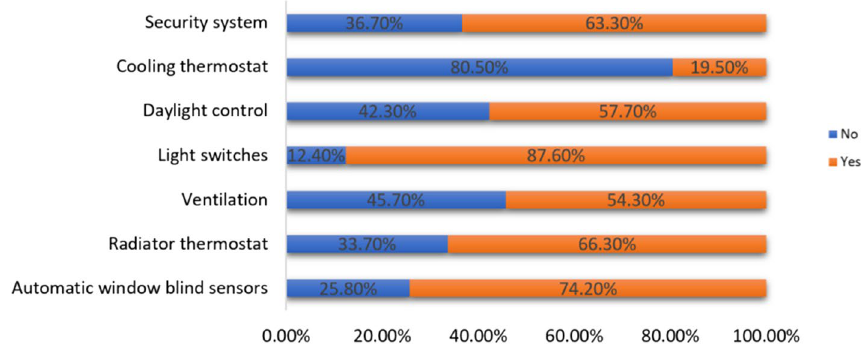
Fig. 8 Awareness of control system installed in classrooms